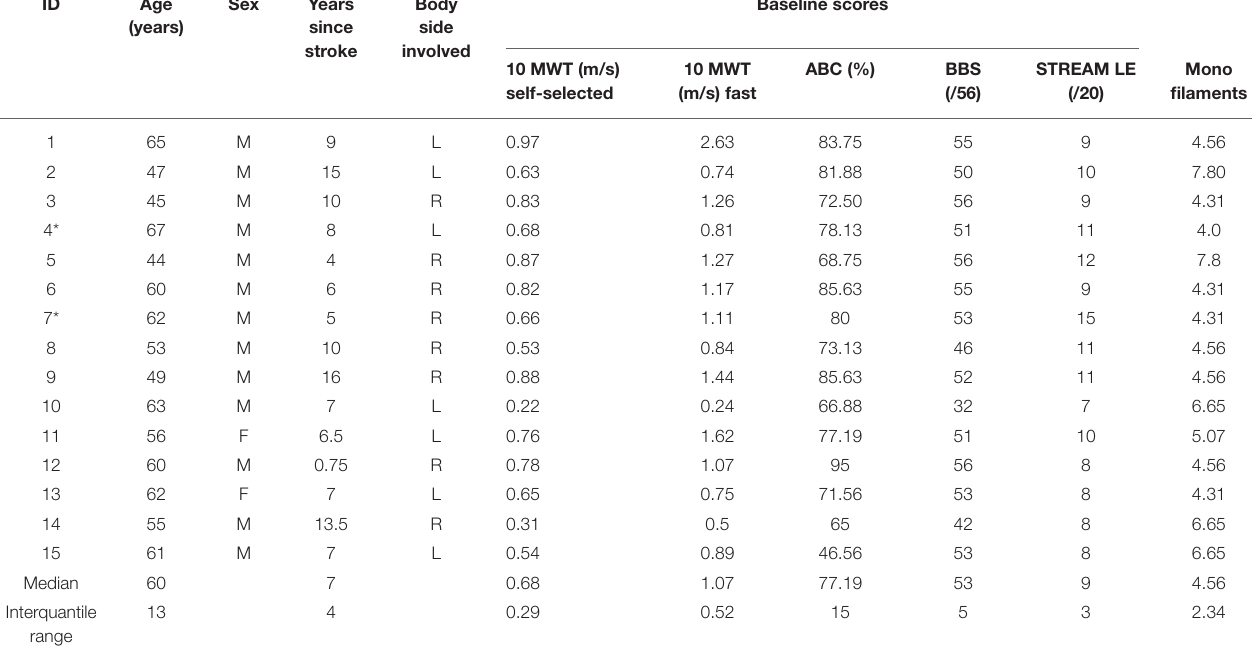
TABLE 1 | Participant demographic and baseline data.